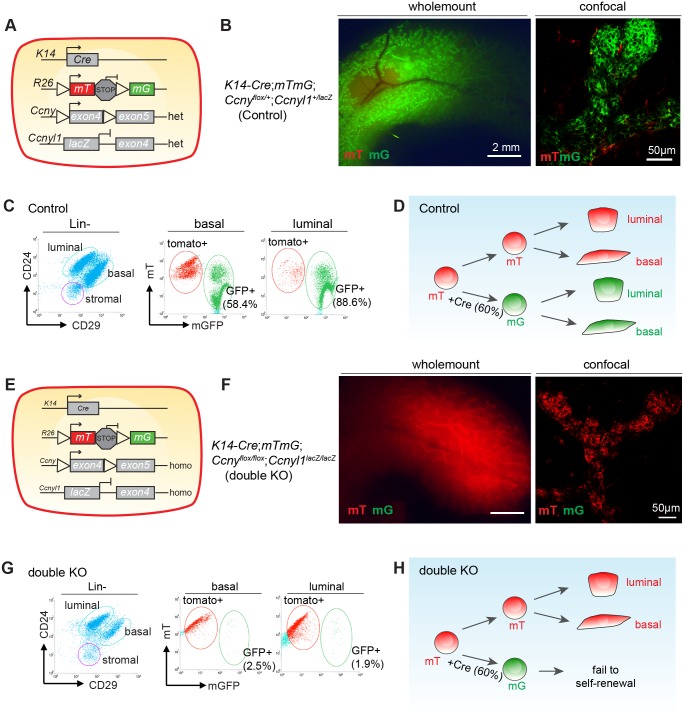
Basal cells with Ccnys deficiency fail to contribute to normal development.(A) Illustration of the control mouse genotypes. (B) Whole-mount analysis and confocal imaging of sections from the 8-week-old control mammary glands indicated that the majority of the cells were GFP-positive. n = 3 mice. (C) FACS analysis to quantify basal and luminal cell populations in a control mammary gland. 58.4% of basal cells (Lin-,CD24+,CD29hi) are GFP-positive, and 88.6% of luminal cells (Lin-,CD24+,CD29low) are GFP-positive. Shown data are representative of three independent experiments. (D) Illustration showing that wildtype stem cells with partial recombination result in chimeric mammary gland of GFP- and tdTomato-positive cells. (E) Illustration of the double knockout (DKO) mouse genotypes. (F) Whole-mount analysis and confocal imaging of sections from the 8-week-old DKO mammary glands indicated that most cells were tdTomato-positive. n = 3 mice. (G) FACS analysis to quantify basal and luminal cell populations in a DKO mammary gland. Only 2.5% of basal cells (Lin-,CD24+,CD29hi) are GFP positive, and 1.9% of luminal cells (Lin-,CD24+,CD29low) are GFP-positive. Shown data are representative of three independent experiments. (H) Illustration showing that Ccnys deficiency in stem/progenitor cells leads to self-renewal failure and loss in competition with wildtype stem cells.